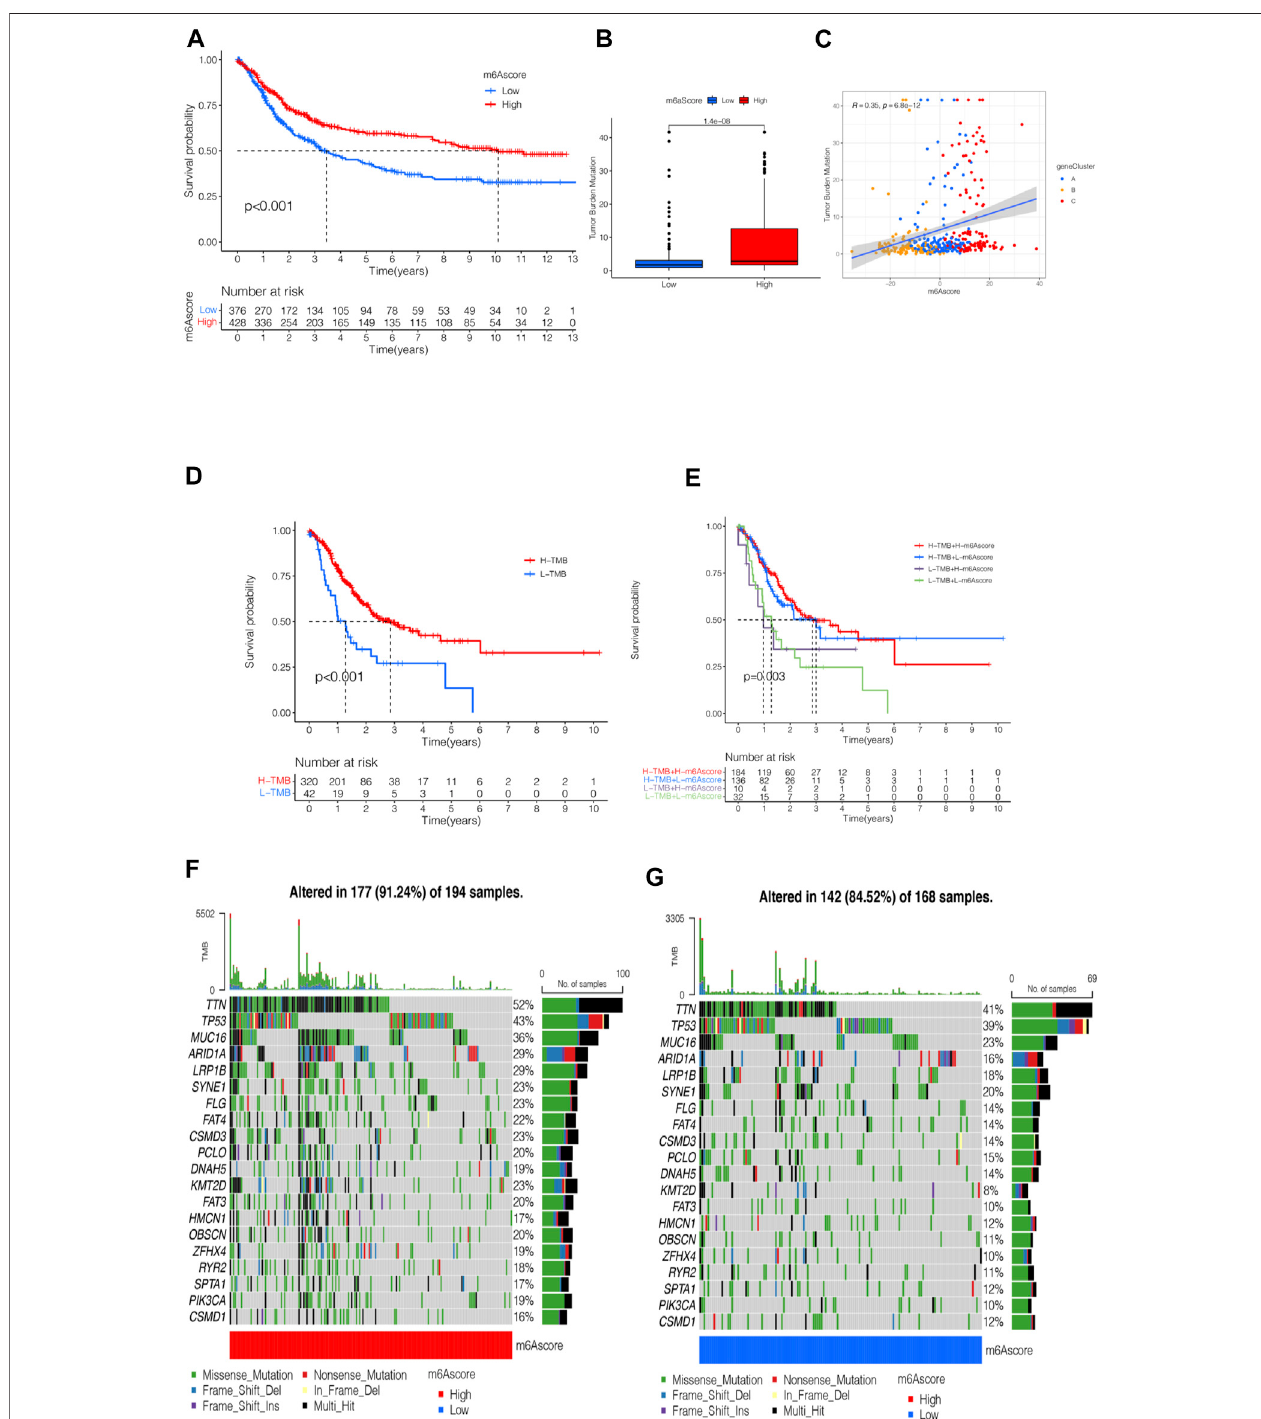
FIGURE 6 | m6A scores ’ clinical prognosis analysis and somatic tumor mutations. (A) Survival analysis of high- and low-m6A score groups using Kaplan-Meier curves ( p < 0.001, Log-rank test). (B) Strati fi ed analysis of the m6A score for STAD patients by tumor mutation burden ( p < 0.001, Wilcoxon test). (C) A scatter plot describing the positive correlation betweenthe m6A scoreand TMB. (D) SurvivalanalysisofTMB ( p < 0.001,Log-ranktest). (E) SurvivalanalysisofTMB combined with m6A score ( p = 0.003, Log-rank test). (F) Waterfall chart of the high-m6A score group. (G) Waterfall chart of the low-m6A score group.